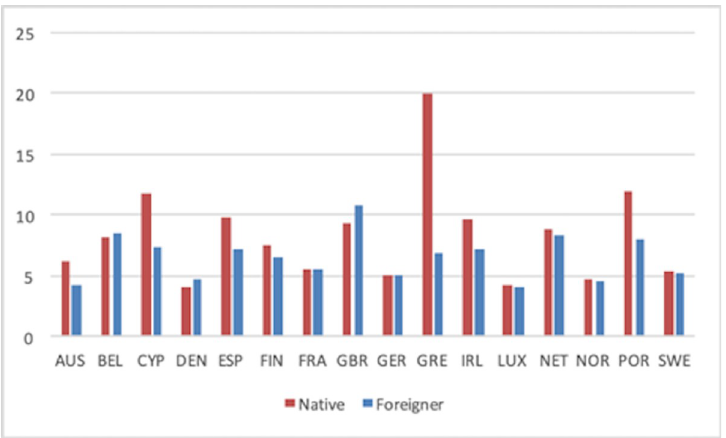
Fig 7. Self-employment rate (Own-account workers) by countries (1999–2018